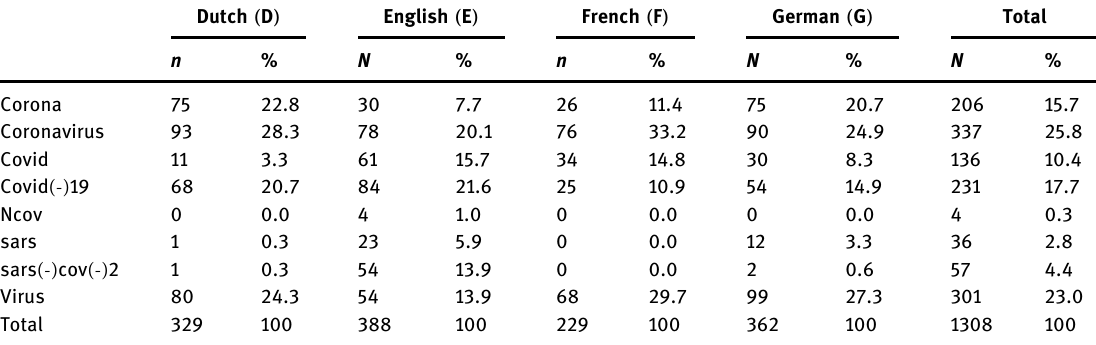
Table 2: Overview of the number of associated words across 10 months per language per seed term after removal of noise Dutch ( D ) English ( E